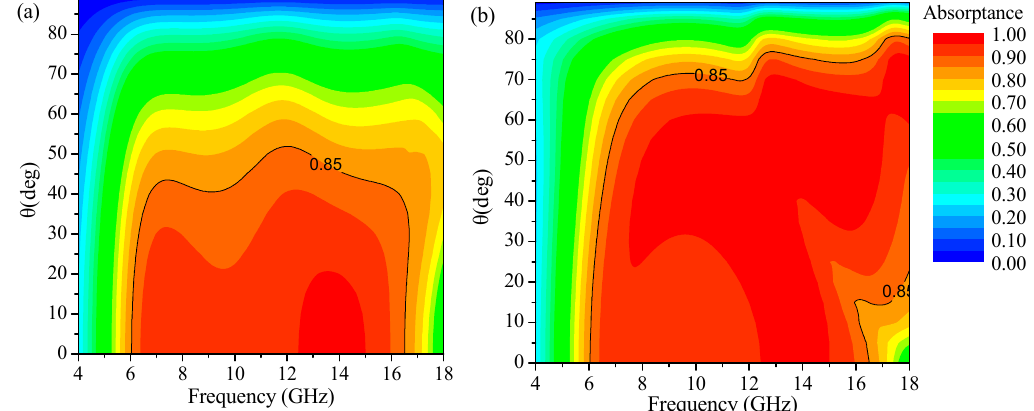
Figure 6. Absorption performance under different incident angles θ , for ( a ) TE and ( b ) TM polarizations.